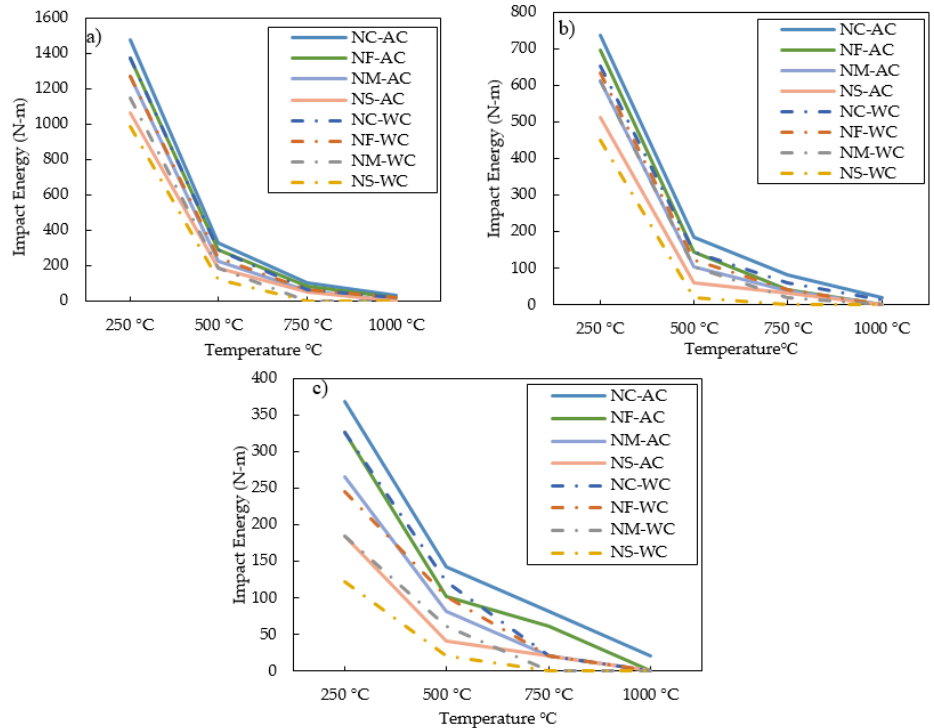
Figure 4. Impact energy versus temperature of M30 grade concrete with various percentages of